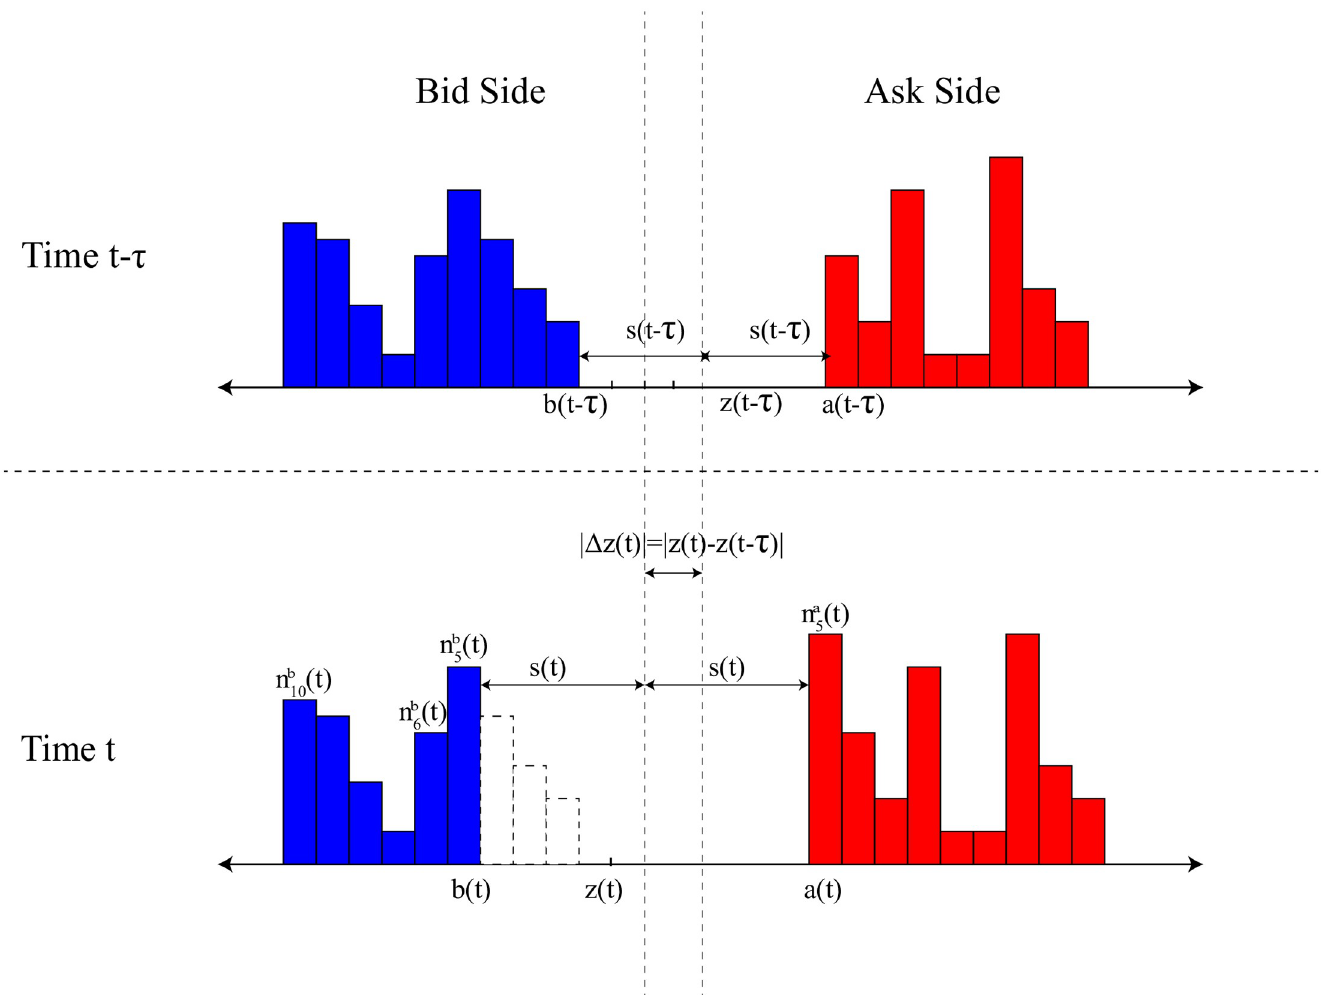
Fig 3. The change in order book from time t − τ to time t . The blue orders and red orders represent bid orders and ask orders, respectively.